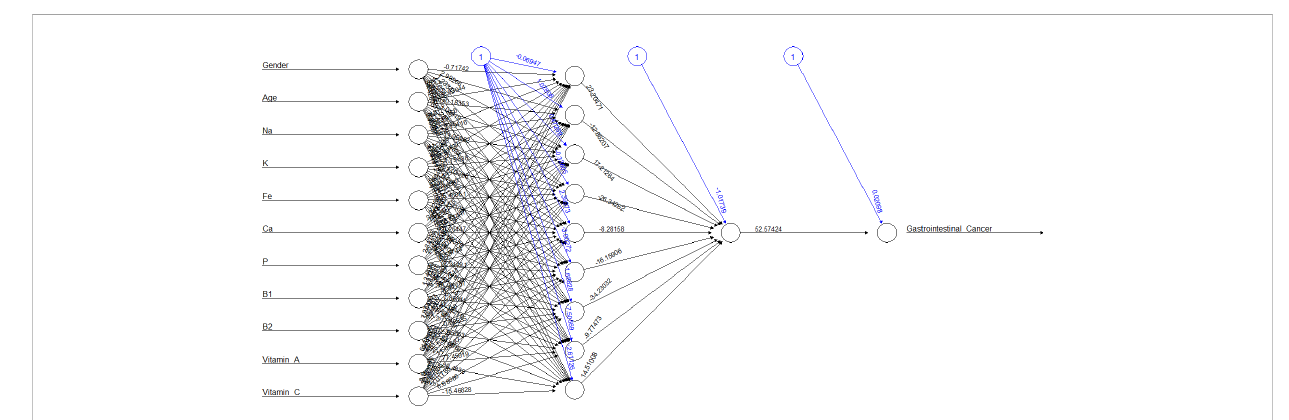
FIGURE 3 The ANN on the training dataset of